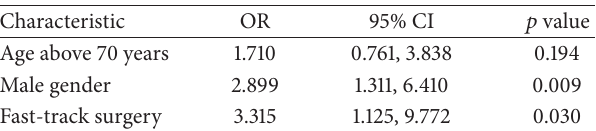
Table 3: Regression analysis of risk for infection-related revision surgery ( 𝑛 =